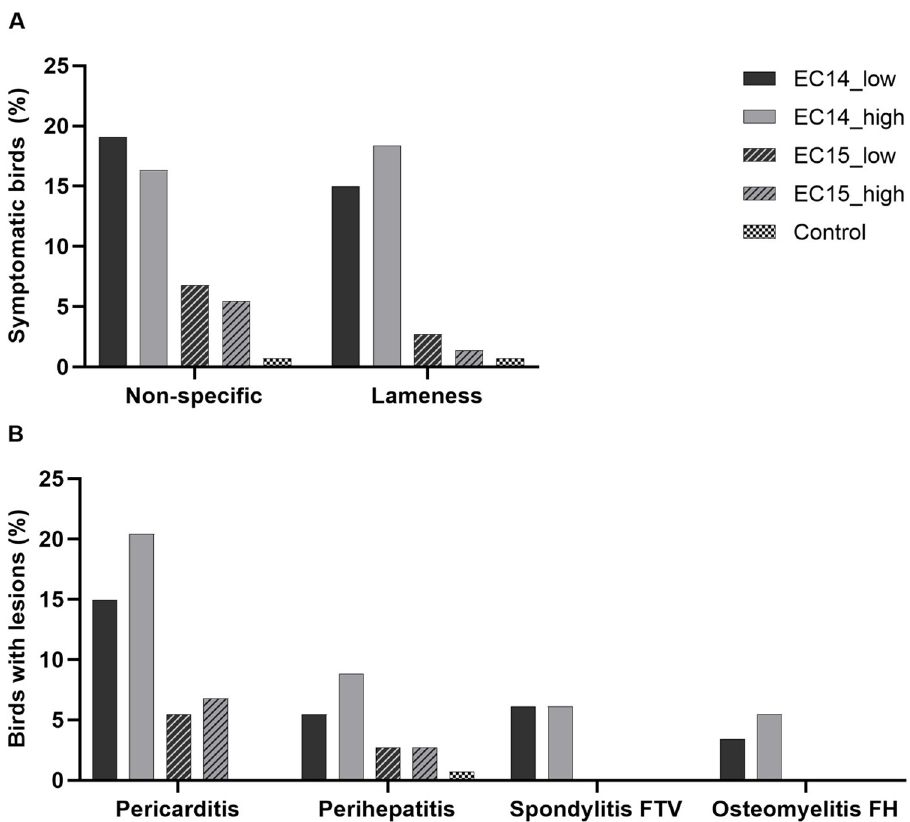
Fig 1. Clinical signs (A) and pathologic lesions (B) observed during the experiment. (A) Non-specific symptoms include depression, ruffled feathers, and closed eyes. Lameness includes all stages from mild to completely paralyzed. (B) Spondylitis FTV = abscess was found at the free thoracic vertebra, FH = femoral head. N = 147 per group in the EC-infected groups, N = 143 in the control